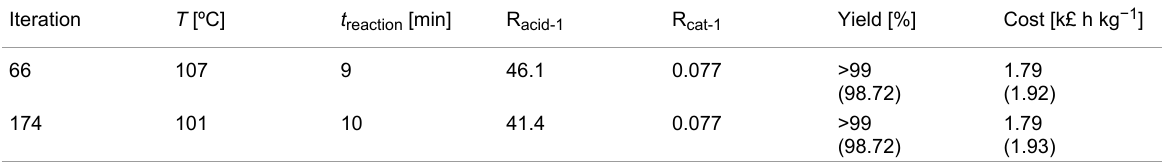
Table 4: Experimental conditions and results of the experimental validation of the two successful predictions that met the target specifications. a